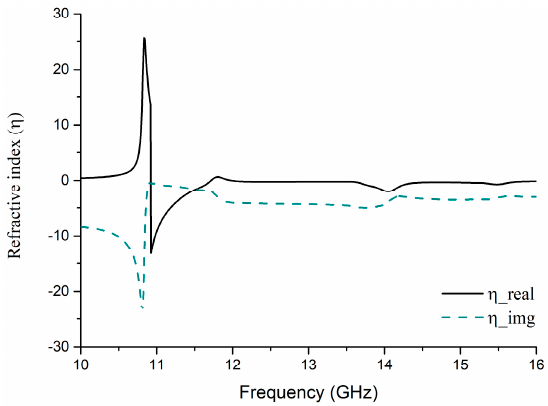
Figure 9. Refractive Index of designed MM absorber in a simulated environment using DRI method.